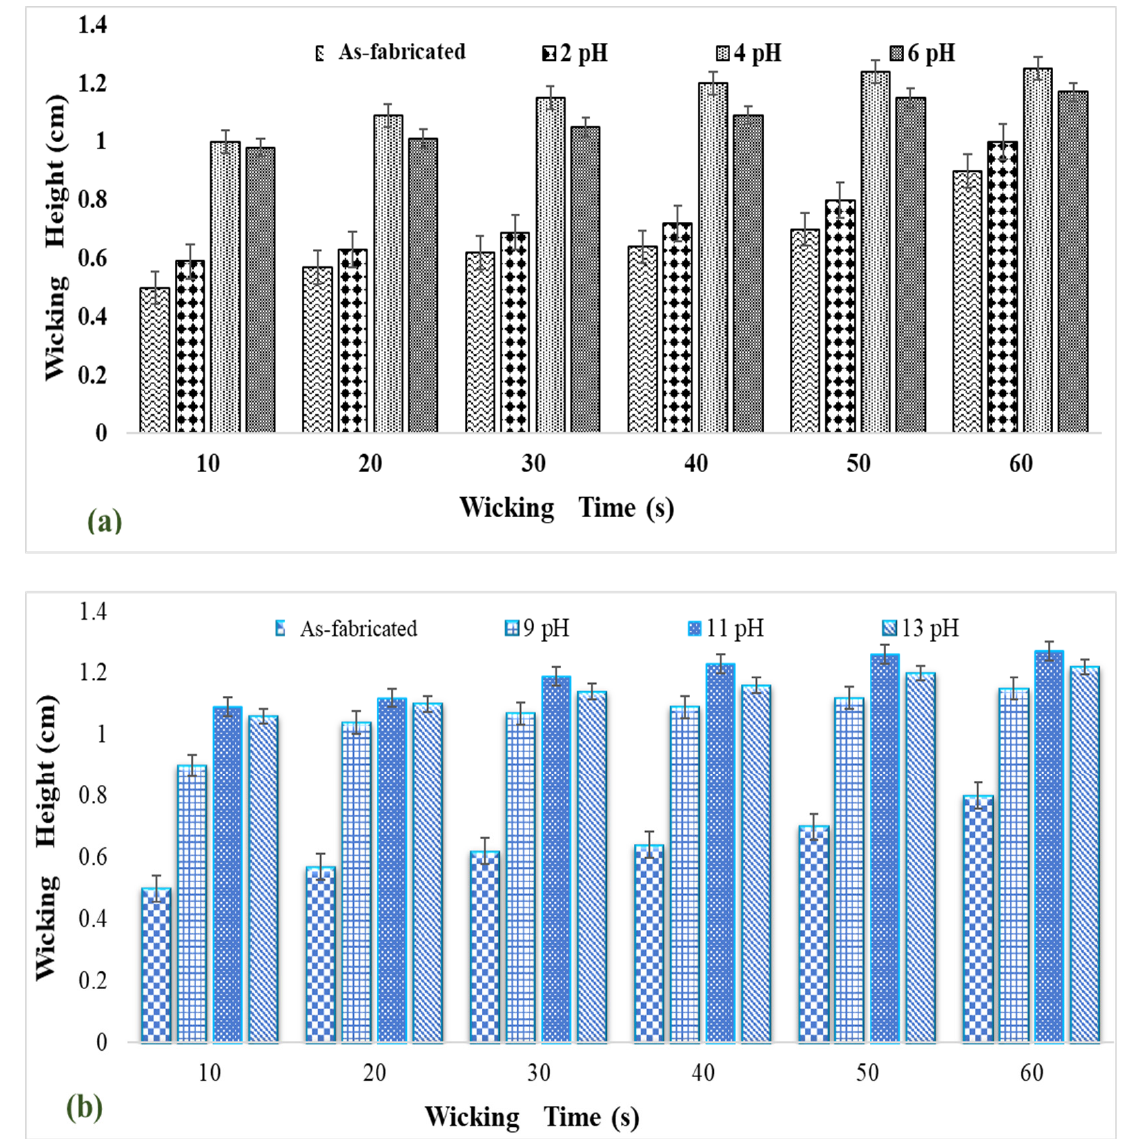
Figure 7. Wickability of ( a ) acidic prewetted nanocalcite @ PF and ( b ) basic prewetted nanocalcite @ PF in water.